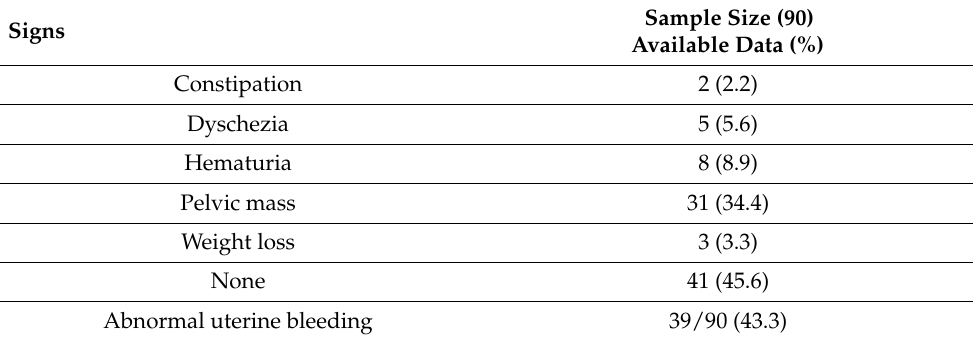
Table 2. Signs/symptoms at clinical